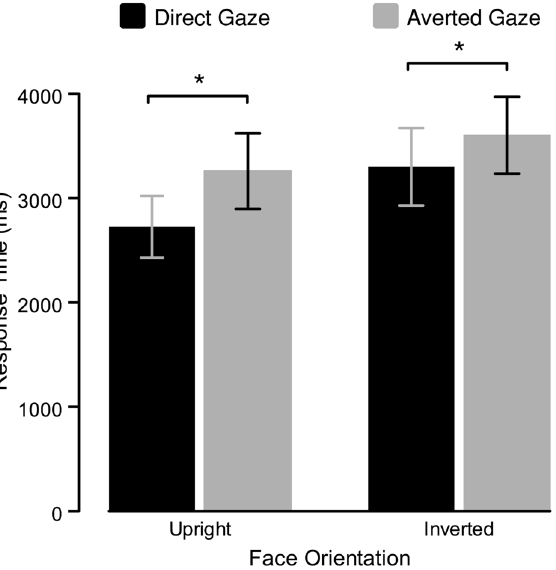
Figure 2. Results of Experiment 1. Bars indicate mean RTs for detection of CFS-masked faces. Asterisks index statistically significant differences. Error bars represent 95% confidence intervals